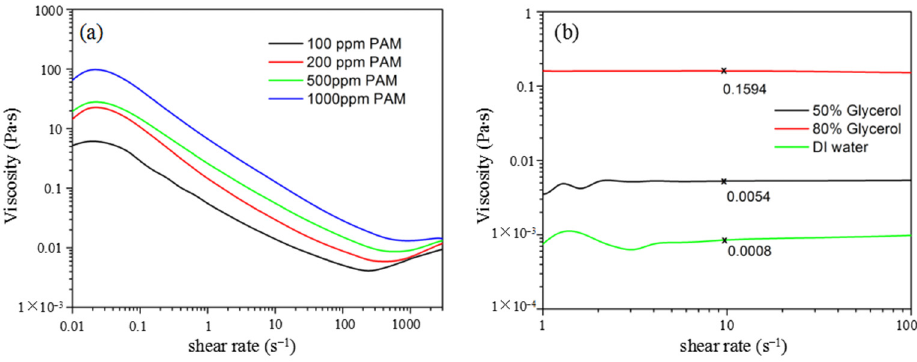
Figure 2. Complex shear modulus of the PAM solutions of ( a ) 100, ( b ) 200, ( c ) 500, and ( d ) 1000 ppm.